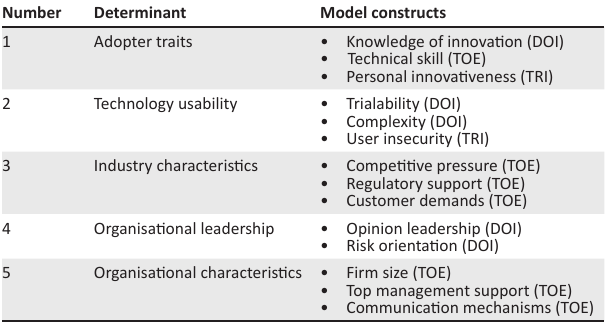
TABLE 1: Determinants and constructs supporting the conceptual model.